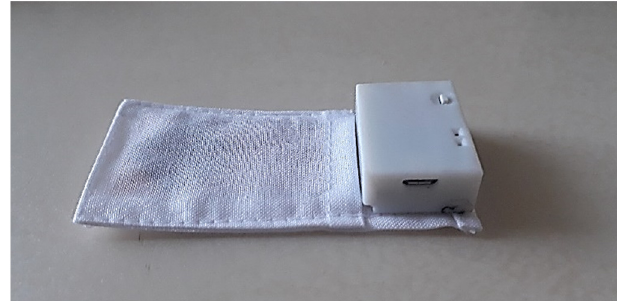
Figure A1. Placement of the arm with the AVF to be tested.